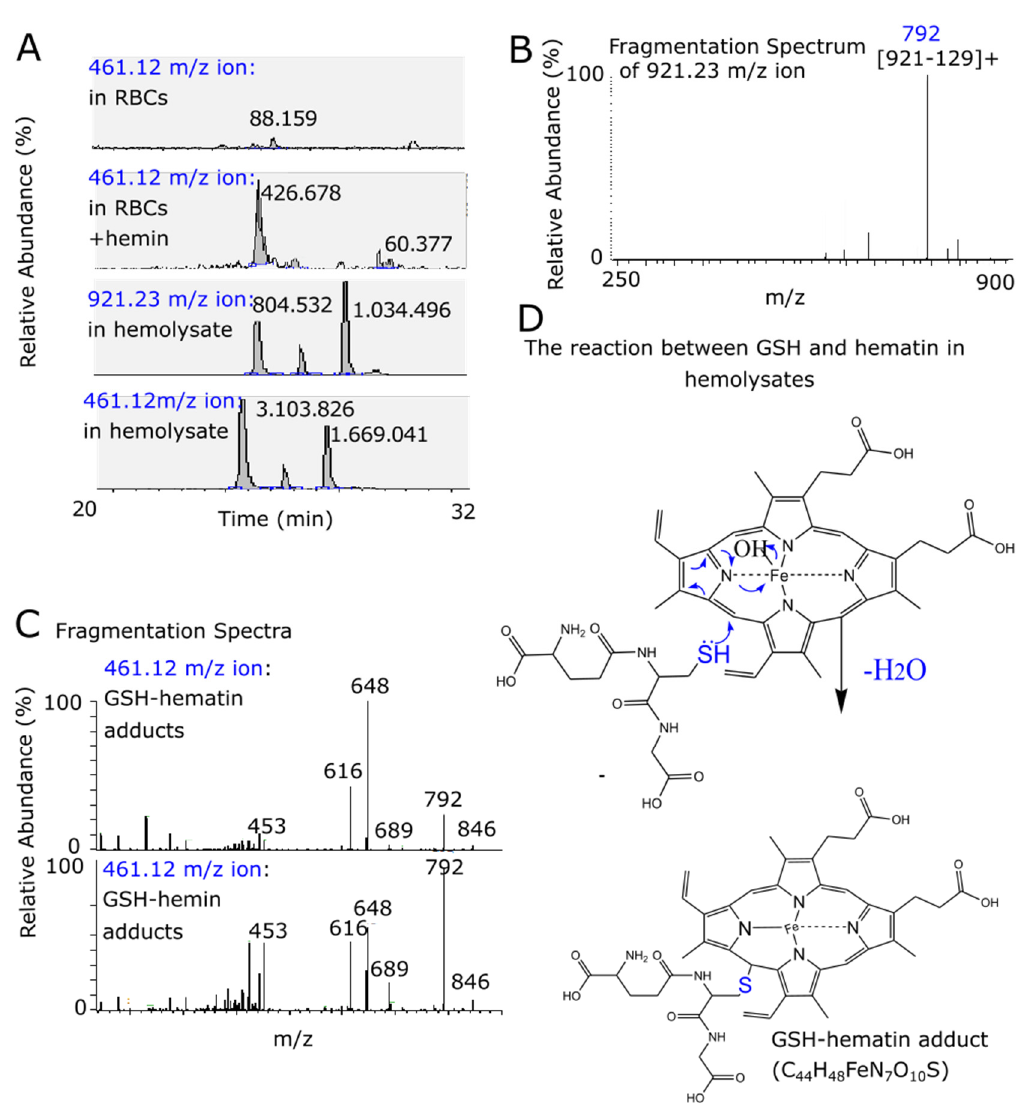
Figure 7. Identification of the 461.12 m/z and 921.23 m/z ions corresponding to GSH–hemin/hematin adducts in the hemolysates of human RBCs. ( A ) Ion spectra of the molecular ions detected at RBCs, as indicated. RBCs aliquots (~2 × 10 9 ) were either proceeded with immediately, or incubated with 20 μΜ hemin (RPMI, 37 °C, 30 min) [these conditions were set to ”load” the RBCs with hemin, without hemolysis being provoked [28]] or lysed with water in the presence of acetonitrile (37 °C, 60 min) prior to the extraction. The quantification of the ion peaks is shown near each ion chromato- graph. ( B ) The fragmentation spectrum of the 921.23 m/z ion, corresponding to (M1+H −Η 2) + of the proposed GSH–hemin/hematin adduct (C 44 H 48 FeN 7 O 10 S). ( C ) Paired comparison of MS2 spectra of the 461.12 m/z ion detected at hemolysates and found in the in vitro reaction between GSH and hemin. ( D ) The mechanism of GSH–hematin adducts formation (one isomer is shown).